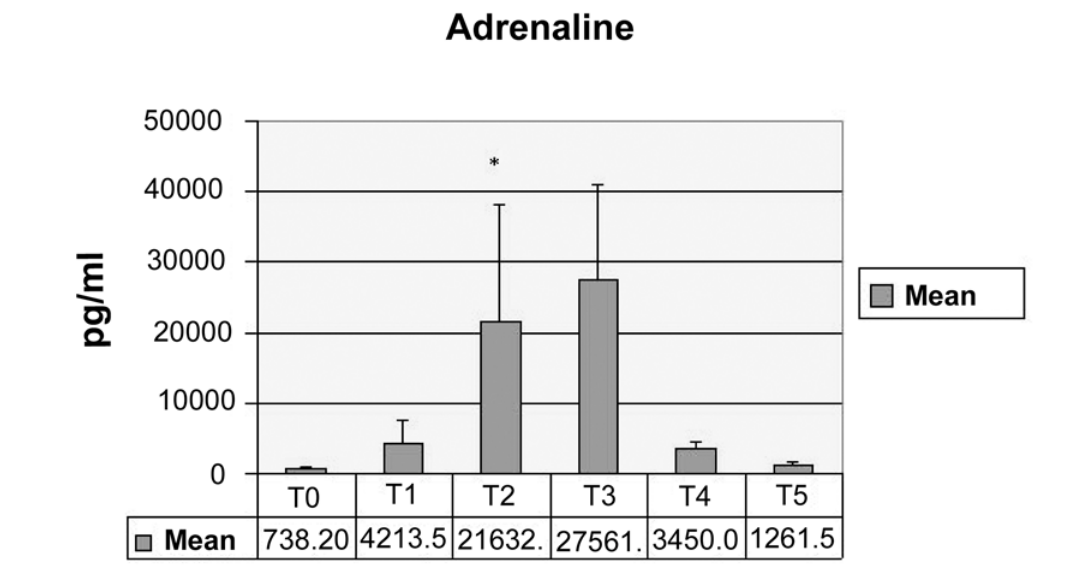
Figure 2 – Mean serum adrenaline concentration at different